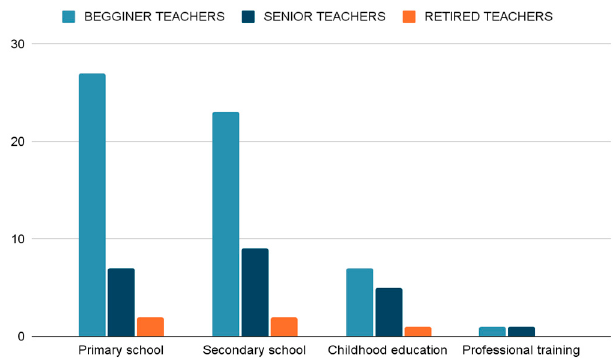
Figure 4. Selected studies according to educational context and teachers.